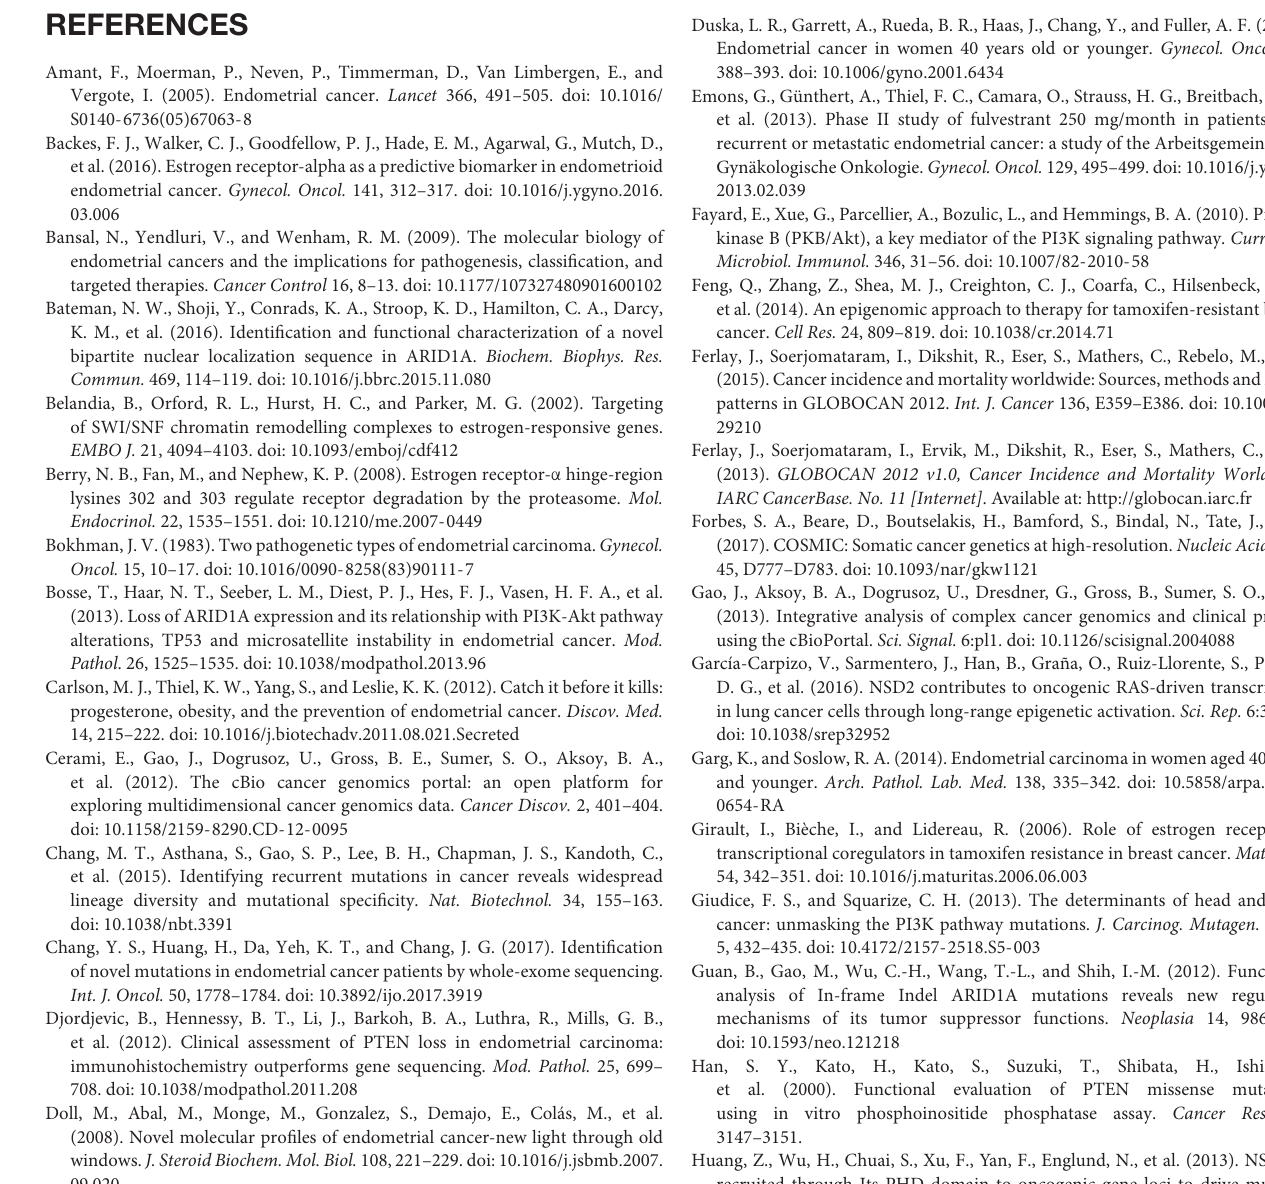
FIGURE S2 | Mutations distribution across exon and functional domain of (a) PTEN , (b) ARID1A , (c) ERBB3 , and (d) WHSC1 . Any position with a mutation obtains a circle; the length of the line depends on the number of mutations detected at that codon. The gray bar represents the entire protein with the different amino acid positions (aa). The colored boxes are specific functional domains. On top of the lollipops variants are annotated as the amino-acid change at that specific site. Blue letter indicates mutation occur in ER positive subtype while green letter indicate mutation occur in ER negative subtype of our analysis. TABLE S1 | Ion Ampliseq TM comprehensive cancer panel. TABLE S2 | Primer’s sequence used for Sanger validation. TABLE S3 | WHSC1 mutant primer for site-directed mutagenesis. TABLE S4 | Somatic alterations among DNA repair gene in hypermutated patient sample.